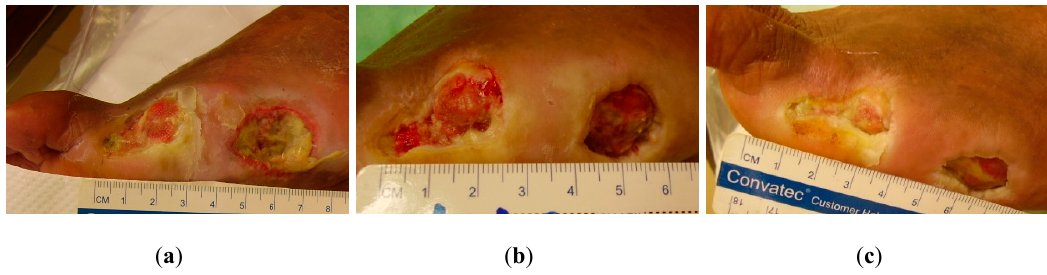
Figure 4. Case 4: ( a ) the wound at the start of MGH therapy (day 0); ( b ) resolution of infection and clear progression of wound healing after five weeks of treatment; ( c ) advanced healing of the wound after 11 weeks of MGH therapy.